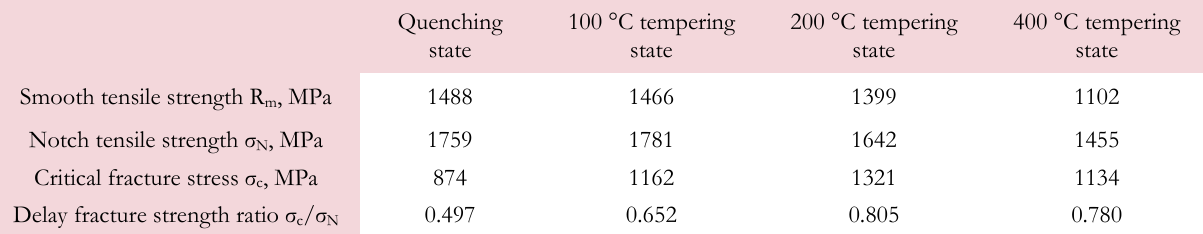
Quenching 100 °C tempering state state